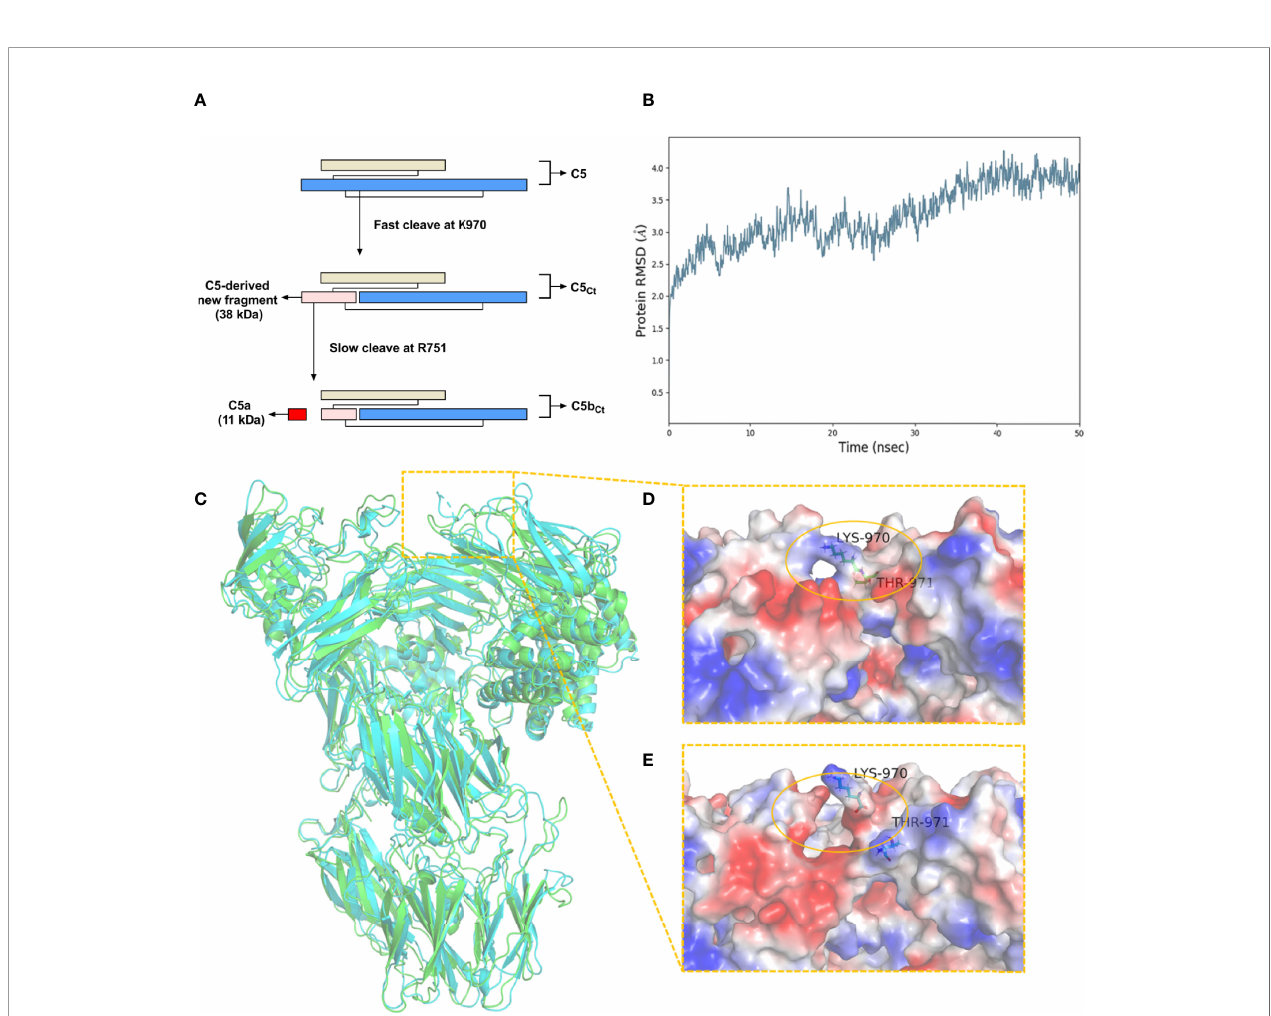
FIGURE 2 | The unique cleavage mechanism of C5 induced by C . trachomatis infection. (A) The cleavage pattern and cleavage sites of C5 induced by C. trachomatis infection. (B) Plot of RMSD for C5 Ct for 50ns of simulation. (C) The superposition of the structure of C5 (green) and C5 Ct (cyan). (D) A close-up view of the electrostatic surface of C5 at residues 970-971. (E) A close-up view of the electrostatic surface of C5 Ct after peptide bond breaking between residues